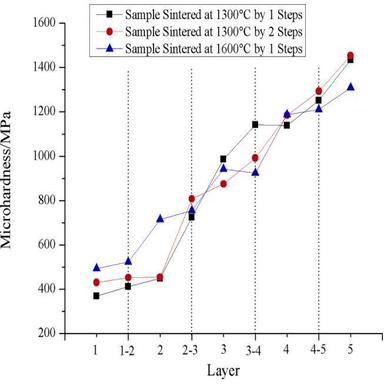
Microhardness of different layers in samples.